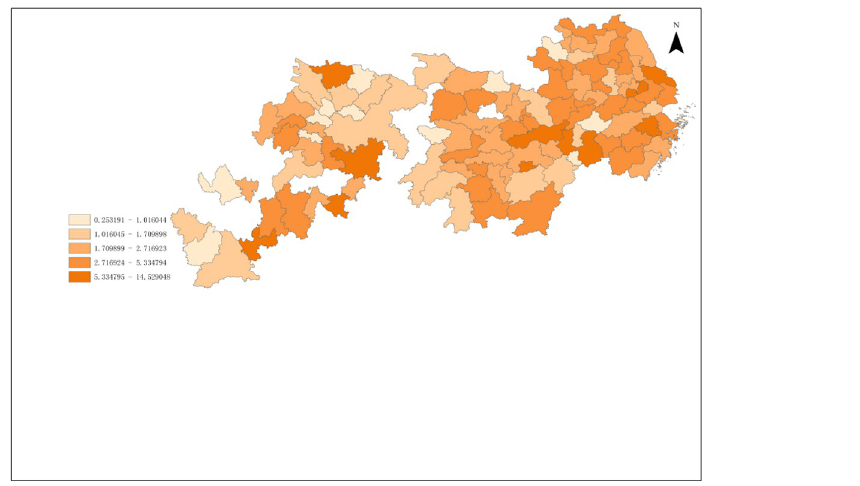
Fig 10. Industrial technology progress of cities in Yangtze River Economic